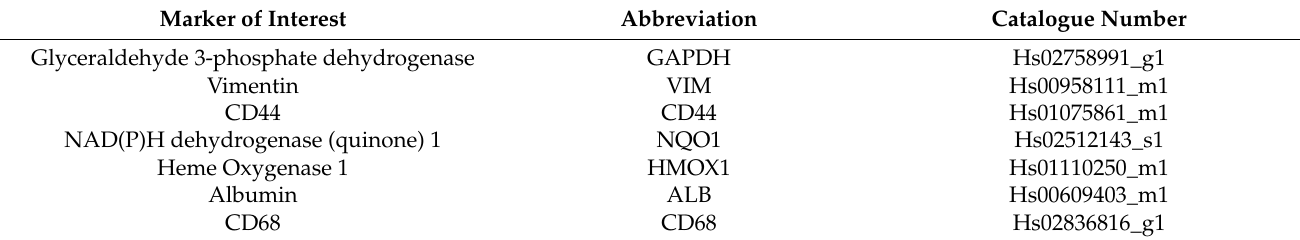
Table 2. List of TaqMan